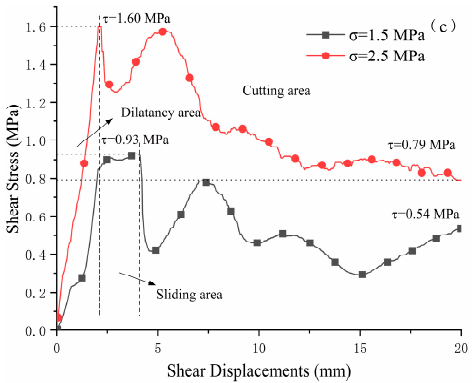
Figure 4. Shear deformation curves of joint surfaces with different roughness under different normal stresses: ( a ) joint roughness is 0°; ( b ) joint roughness is 15°; ( c ) joint roughness is 30°.